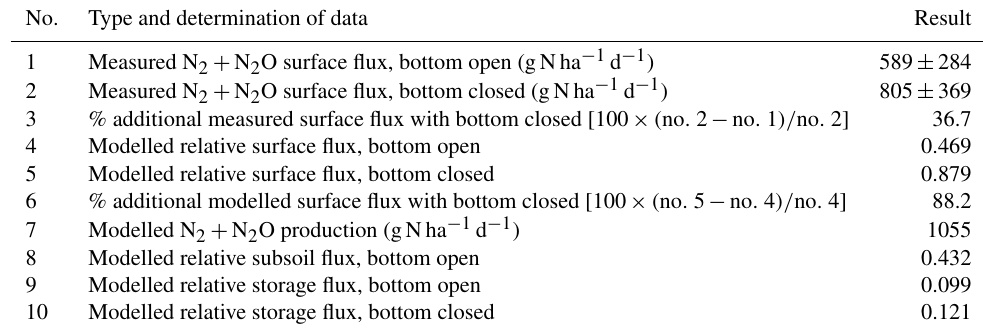
Table 5. N 2 + N 2 O fluxes of field experiments with 2h chamber closing with and without closed bottom in comparison with modelled data.